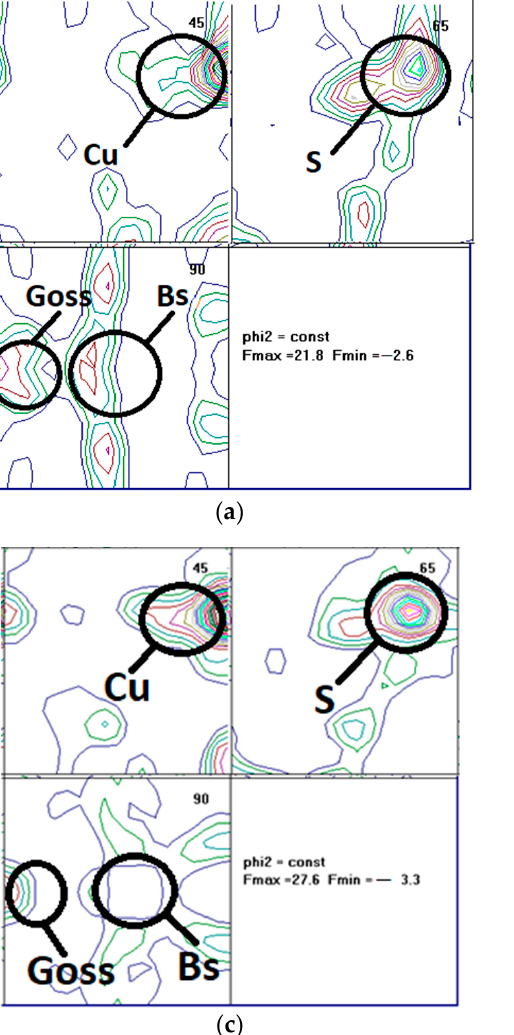
Figure 5. ODF , aluminum 99.95% (for composition refer to Table 1) compressed under plain strain to 80% engineering strain ( a ) strain rate 1 s − 1 , temperature 300 ◦ C, ( b ) strain rate 1 s − 1 , temperature 450 ◦ C, ( c ) strain rate 10 s − 1 , temperature 300 ◦ C ( d ) strain rate 10 s − 1 , temperature 450 ◦